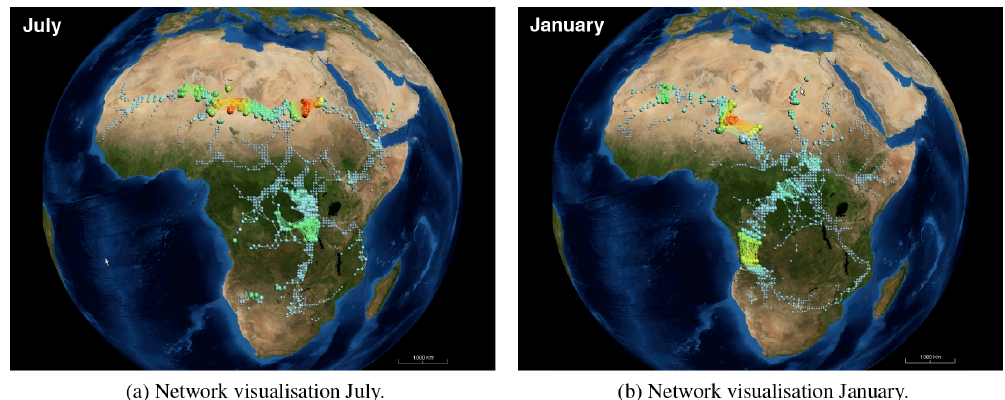
Figure 20. Rainfall network of Africa for July and January, unveiling regions that correspond to known convergence zones (CGV). The network visualisation (bottom row) has been filtered to hide nodes with low shortest-path betweenness to highlight regions corresponding to important moisture convergence zones. Additionally, the node attributes degree (node size) and shortest-path betweenness (node colour: blue shades → small values; red shades → large values) are